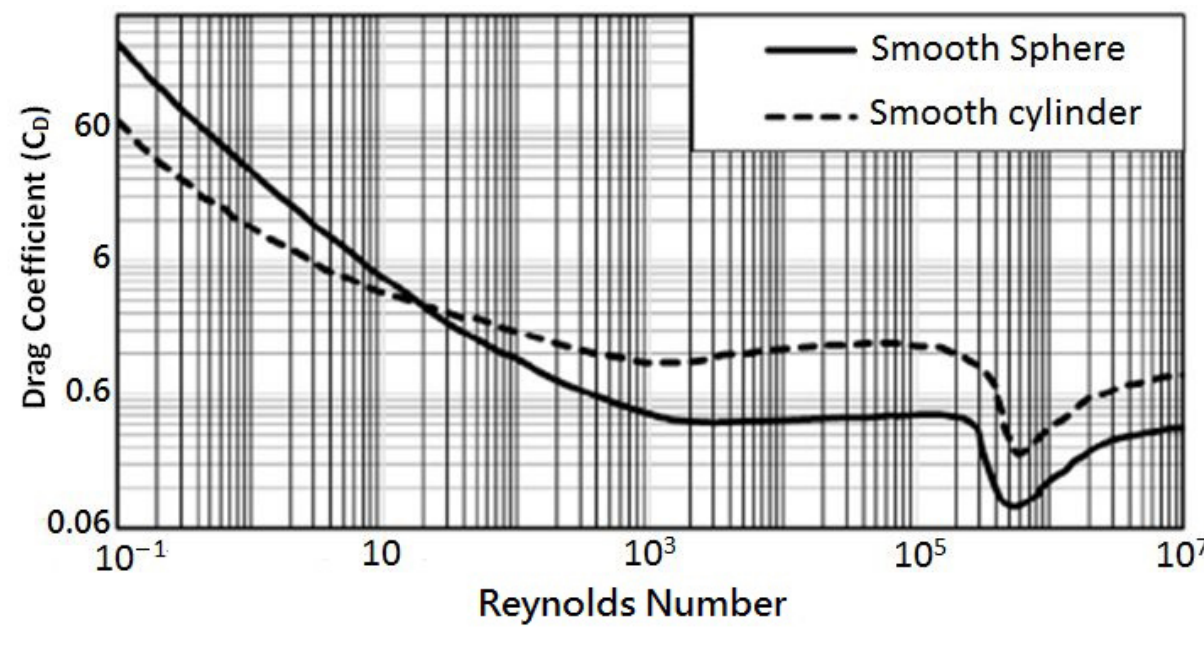
Figure 12. Drag coefficient of ideal sphere and circular cylinder by